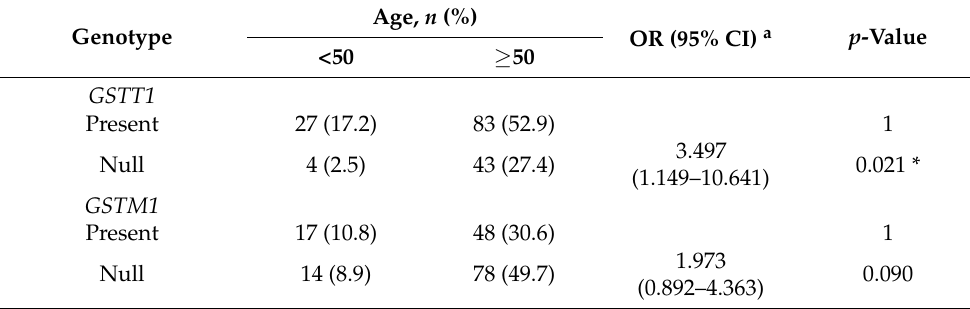
Table 2. Association of GSTT1 and GSTM1 genotypes with breast cancer patients’